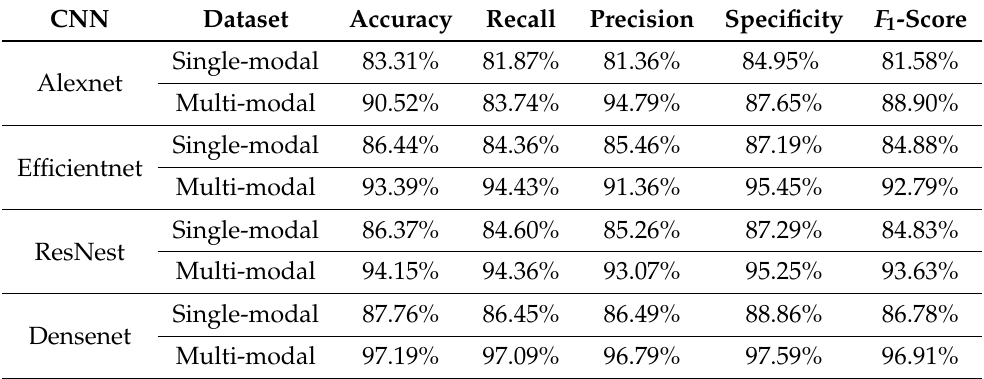
Table 4. Experimental